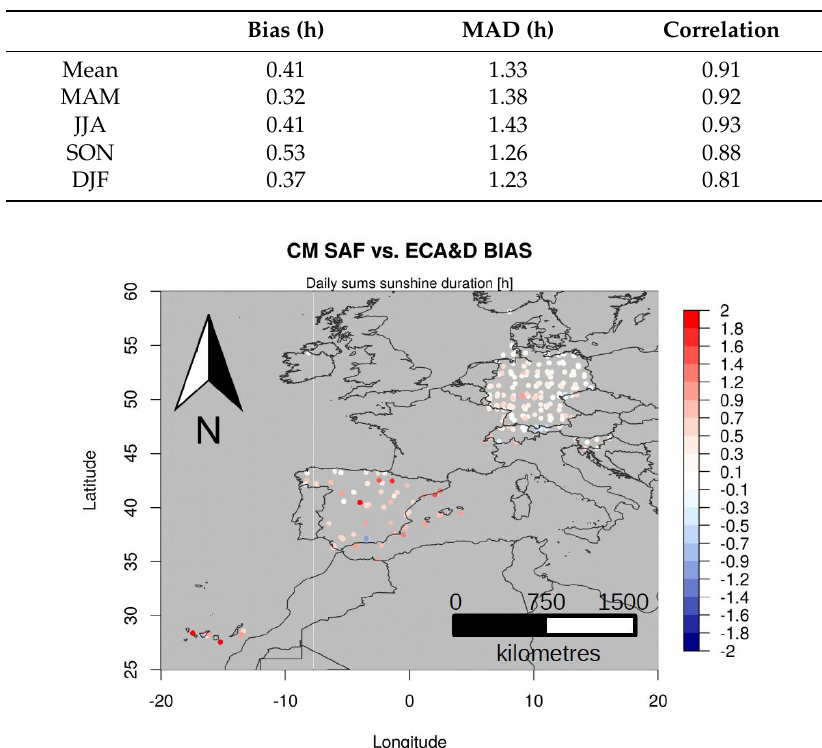
Figure 2. Spatial distribution of the bias (h) between daily SDU and ECA&D for the time period 1983 to 2015.